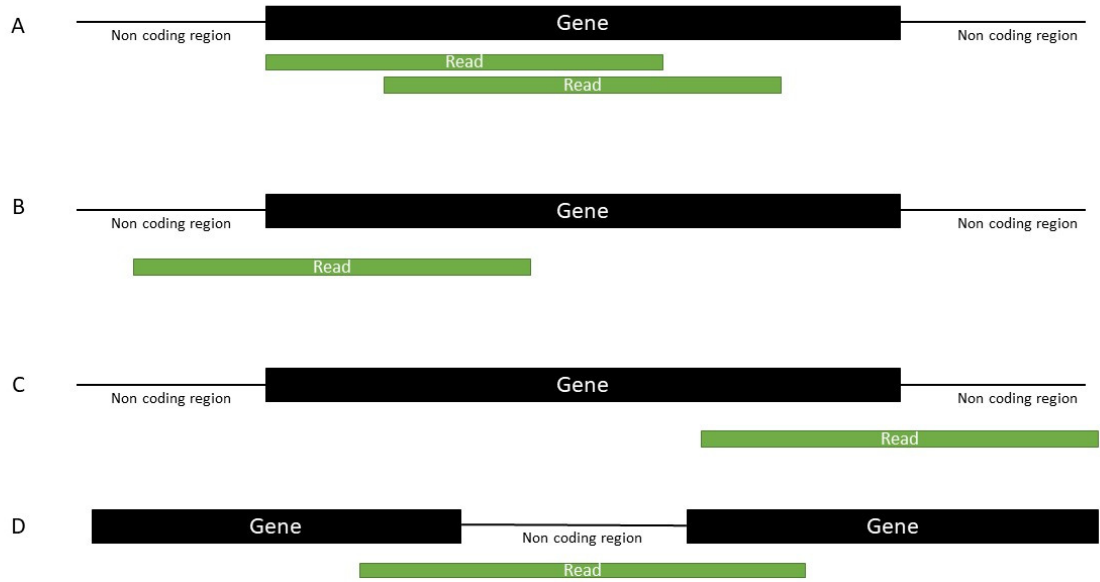
Figure 3. Possible alignments of a mt-ncRNA: ( A ), falls within a gene boundary; ( B ), starts in a non-coding region and overlaps a gene boundary; ( C ), falls in a non-coding region. ( D ), overlaps two gene boundaries.